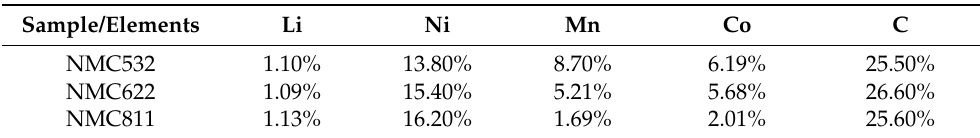
Table 5. Content of metals of interest in the obtained powder fraction in the InduMelt experiments (mass fraction,